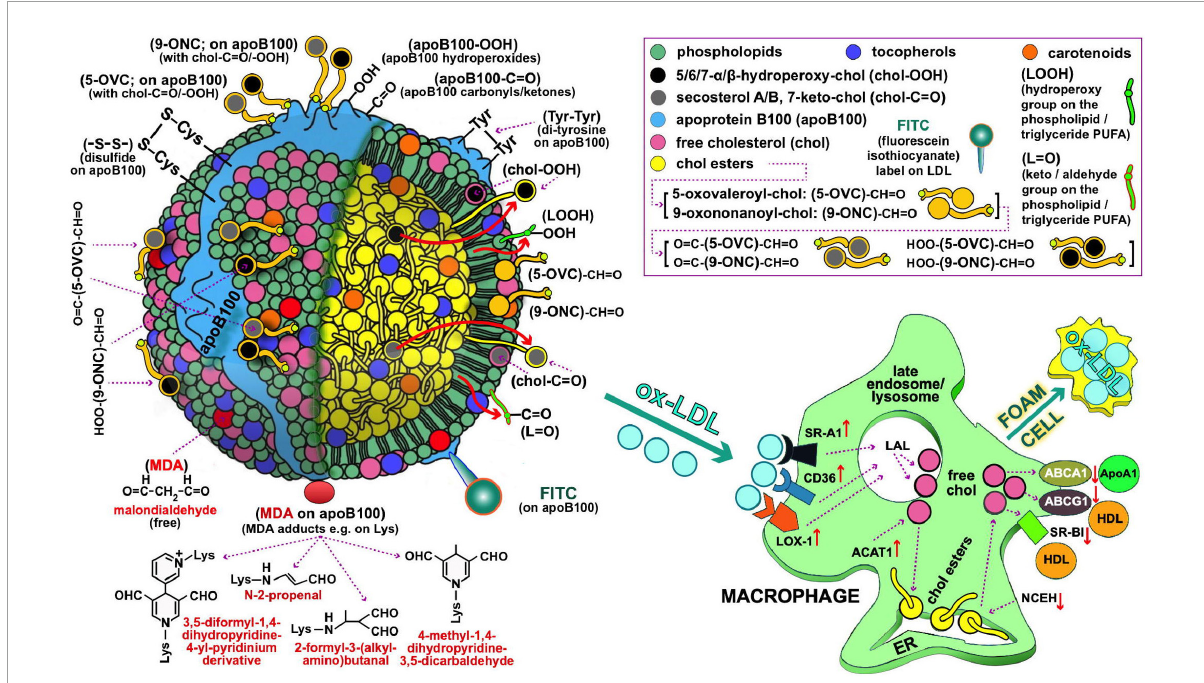
FIGURE1 Oxidized LDL as depicted by possible oxidative modifications of its main components, possibly recognized by macrophages ( left and right panel, respectively) for oxLDL uptake during the course of atherosclerosis development. Starting with the oxidative modifications of the LDL lipid components, clinically important are those of cholesterol (free or esterified) and particularly the following: (i) Those carrying keto-groups (-C=O; i.e., in 7-keto-chol, and secosterol-B and -A with 1 and 2 keto-groups, respectively), to be quantified by a method under development by our lab. (ii) Those having a hydroperoxy group (HOO-; i.e., 5 α -HOO-chol, 5 β -HOO-chol, 6 α -HOO-chol, and 6 β -HOO-chol) (85); there is also the 7-HOO-chol, which is converted to the 7-keto-chol (86). Oxidatively modified cholesterol can also exist in its ester form, and is expected to translocate to the surface of the LDL particle as being polar (shown with large red arrows). Moreover, 5-oxovaleroyl-chol (5-OVC) and 9-oxononanoyl-chol (9-ONC) represent important oxidative modifications on the polyunsaturated fatty acid (PUFA) part of the cholesterol esters (87), which are also expected to translocate to the LDL’s surface due to their polar aldehyde end group [see (5-OVC/9-ONC)-CH=O], as will also translocate their O=C-/HOO-chol modifications [see O=C-/HOO-(5-OVC/9-ONC)-CH=O]. Additionally, these oxidative modifications of 5-OVC and 9-ONC can cross-link with apoB100 due to their very reactive aldehyde end (87). All these aldehydic product can be collectively quantified by a method under development by our lab. PUFA can be also oxidized in lipid hydroperoxides and keto/aldehydes (LOOH and L=O, respectively), and when present in the LDL phospholipids/triglycerides are expected to translocate to the LDL lipid monolayer surface due to their polarity (depicted by the small red arrows); LOOH can further oxidize to malondialdehyde (MDA), which could accumulate on the LDL surface as being polar (see depicted as red circles), or react with certain amino acids (88) in apoB100 (depicted as red oval). L=O can be quantified by a method under development by our lab. Extending to apoB100 oxidative modifications, of particular interest are the following: the OS-induced formation of dityrosines (89), and disulfides (between two Cys; -S-S-) (90), hydroperoxides (apoB100-OOH) (50), and carbonyls (apoB100-C=O) (91, 92), the last three by methods developed by our lab. As illustrated in (right) panel, macrophages recognize and bind oxLDL with several scavenger receptors (SR, e.g., SR-A1, CD36, and LOX-1). Future studies, could address quantitatively oxLDL uptake by macrophages by flow cytometry in order to be used as an ex vivo clinical marker for CVD risk assessment and for studies to identify the oxidative modifications on oxLDL recognized by macrophages. In such studies, oxLDL from patients with diseases prone to atherosclerosis development, and LDL from healthy subjects to be used either as control or artificially turned to oxLDL with known oxidative modifications, can be labeled with, e.g., fluorescein isothiocyanate [FITC; preliminarily achieved by our lab as described elsewhere (93, 94)]. Under normal (healthy) conditions of low OS, lysosomal acid lipase (LAL) in late endosomes/lysosomes, degrades LDL cholesteryl esters (CE) to free cholesterol (chol) and fatty acids, while acyl coenzyme A:cholesterol acyltransferase-1 (ACAT1), contributes to formation of CE from the chol in the endoplasmic reticulum (ER) where they accumulate. Neutral CE hydrolase (NCEH) converts CE to chol that is transported outside the cells via the ATP-binding cassette (ABC) transporters ABCA1 and ABCG1, and also SR-BI, with the latter two passing chol to HDL via apolipoprotein A-1 (ApoA-1), thereby ensuring cholesterol homeostasis control. In high OS-promoted atherosclerosis, this control is deregulated, leading to increased SR expression and subsequent oxLDL elevated uptake. In contrast, expression of the chol transporters ABCA1 and ABCG1 is suppressed, which diminishes cholesterol efflux and promotes its deposition in macrophages. At the same time, ACAT1 and NCEH are upregulated and downregulated, respectively, which leads to accumulation of CE. Concurrent operation of these mechanisms results in excessive deposition of lipids and transformation of macrophages to foam cells, as also outlined elsewhere (95). LDL and macrophage draws are major modifications from Berg et al.